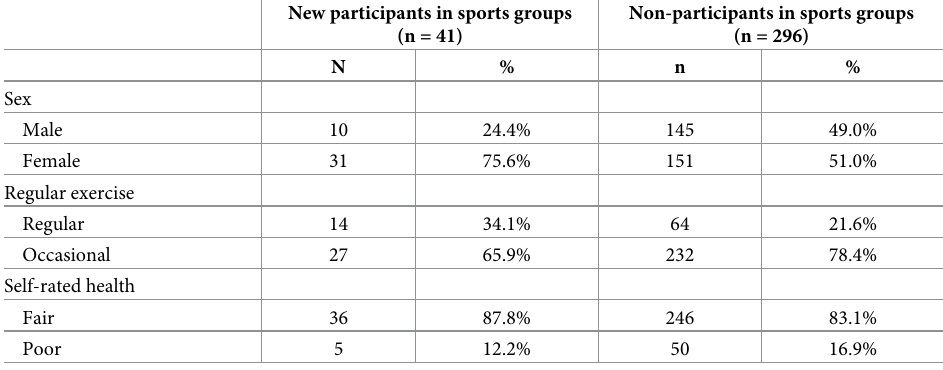
Table 2. Baseline characteristics of older adults according to the status of participation in sports groups at follow- up (categorical variables). New participants in sports groups (n = 41)